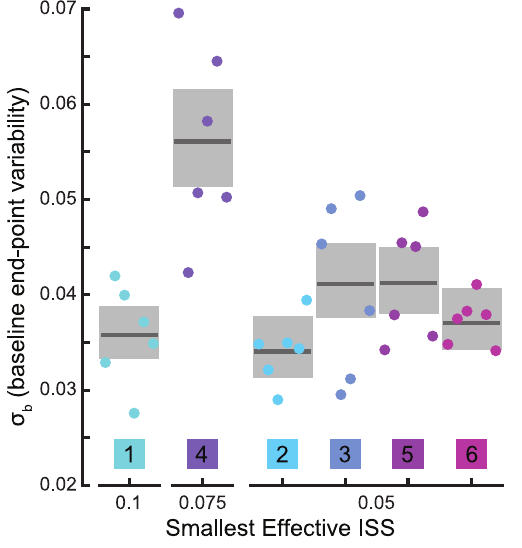
Figure 4. End-point variability and smallest effective ISS. We define baseline end-point variability ( s b ) as: the standard deviation of primary saccade gain during the final 50 trials of the baseline phase. Colored dots are s b calculated for each subject in each condition; dark line segments and grey boxes are across-condition estimates and bootstrapped 95% CIs for each subject (see Methods for details). The smallest effective ISS is the minimum ISS size for which a particular subject showed a significant adaptive decrease in gain (see Figure 2A). Colors and subject numbers as in Figure 2.